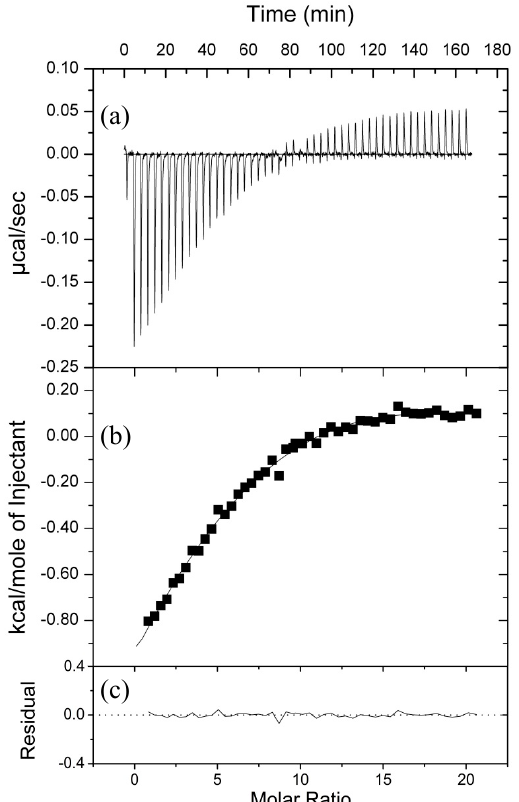
Figure 2. Mg 2+ binding to the DNA 4WJ as measured by isothermal titration calorimetry. ( a ) Raw data and ( b ) normalized integration of the raw data for the titration of 0.85 mM Mg 2+ into a 16 μ M solution of DNA 4WJ; ( c ) Residuals depicted are generated between the actual data and the fit shown. Both solutions contained 5 μ M EDTA, 5 mM Na + , and 10 mM Tris–HCl pH 7.4. Two titrations of 25 × 10- μ L injections were performed and appended using the Concat32 software (MicroCal of Malvern Instruments Ltd., Worchestershire, UK).